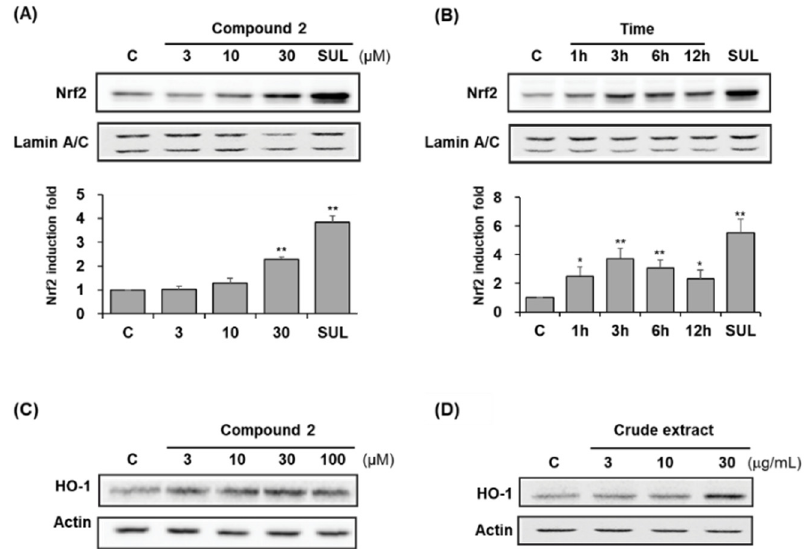
Figure 7. Induction of the nuclear Nrf2 protein and HO-1 levels in HepG2 cells by compound 2 or crude extract. Nuclear Nrf2 protein levels in HepG2 cells exposed to compound 2 for the indicated concentrations ( A ) and treated with 30 μ M compound 2 for the indicated times ( B ). Western blot of HO-1 induced by treatment of compound 2 ( C ) and crude extract ( D ) for the indicated concentrations. Data are presented as the mean ± S.D. ( n = 3). * p < 0.05, ** p < 0.01 (compared with the vehicle-treated control).